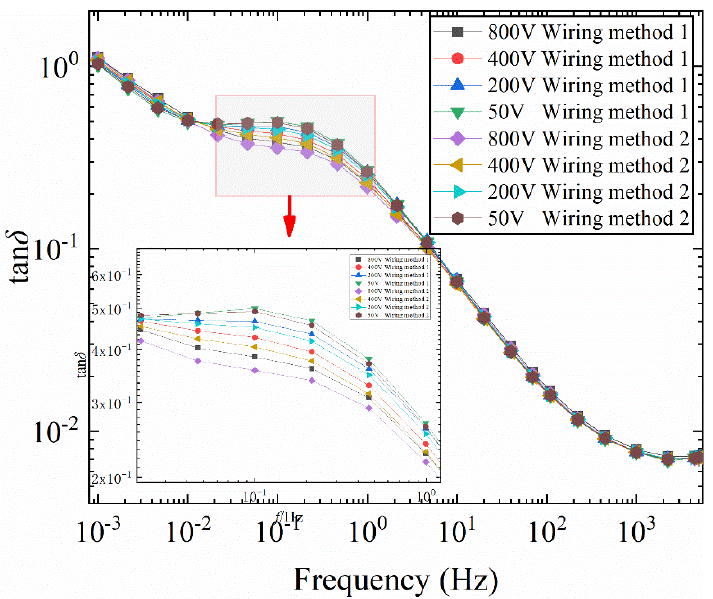
Figure 10. Influence of different wiring methods on tan δ - f curve of bushing model at different voltages (50 °C).